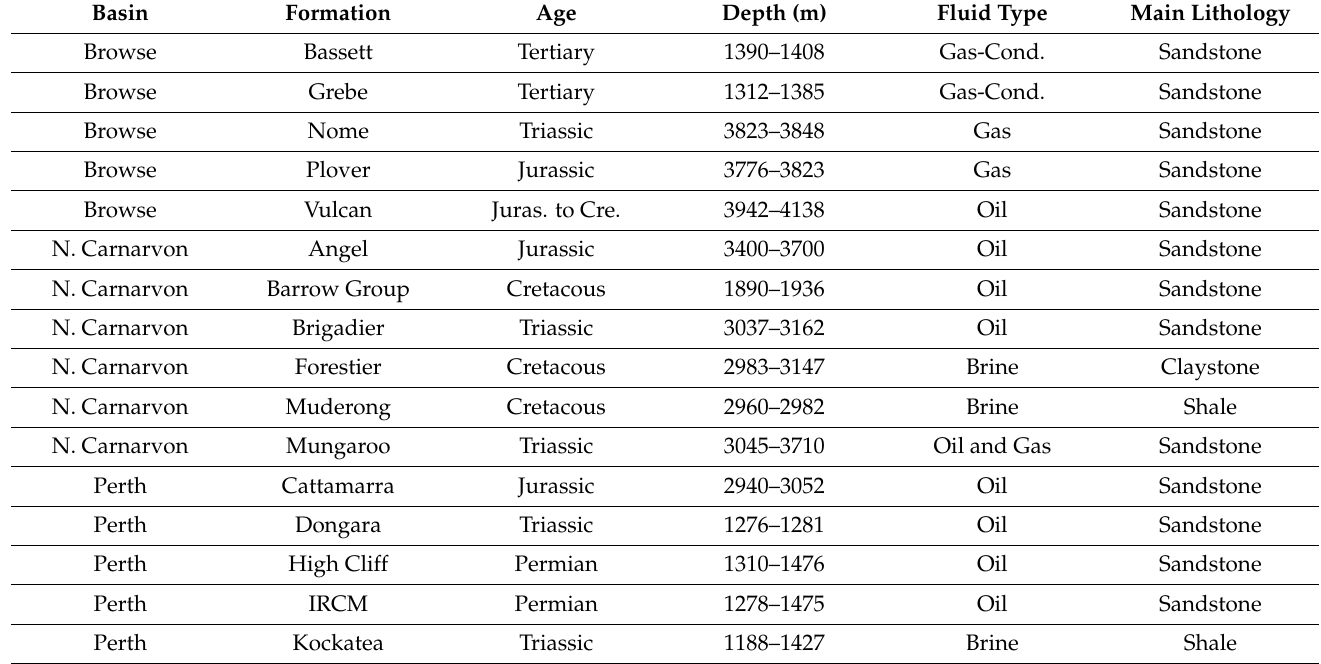
Table 1. The list of the basins, formations, and their details used for this